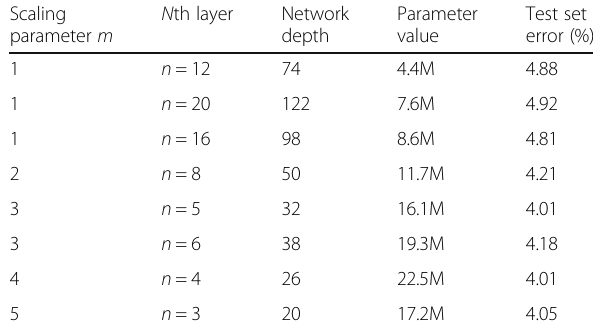
Table 2 Test set error rate for different scaling parameters and